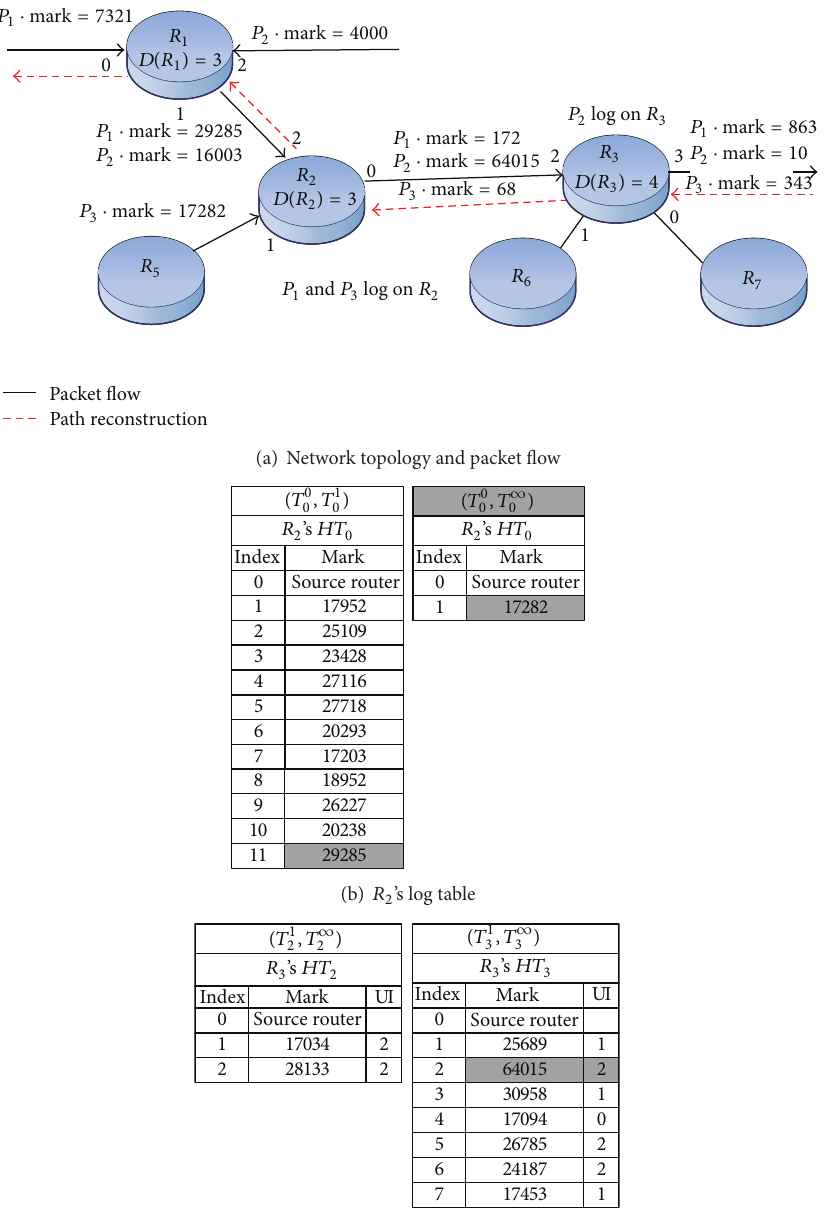
Figure 2: Example of our